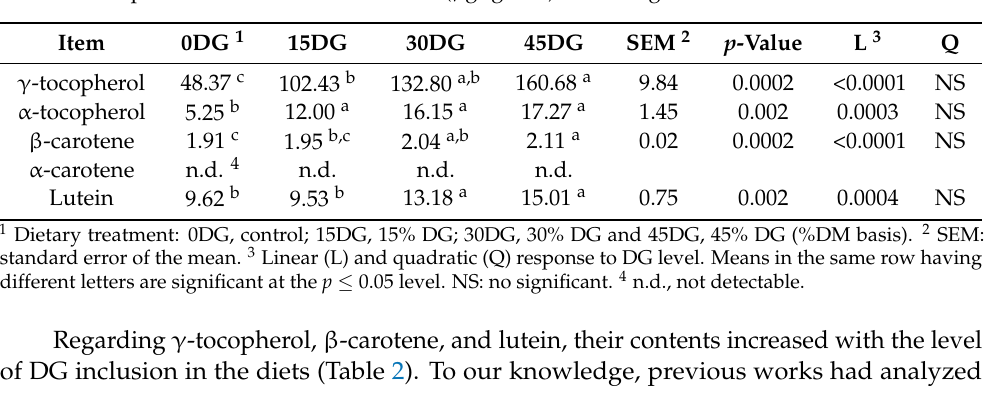
Table 2. Tocopherol and carotenoid contents ( µ g/g DM) in feeding diets 1